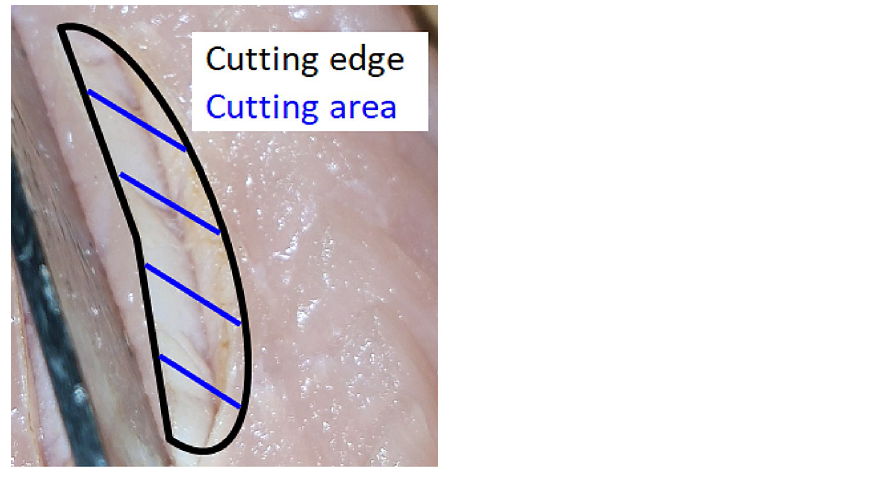
Figure 1. Exemplary cut without much tissue damage. The two methods of scoring are the cutting edge (CE); blue scoring of the cutting area